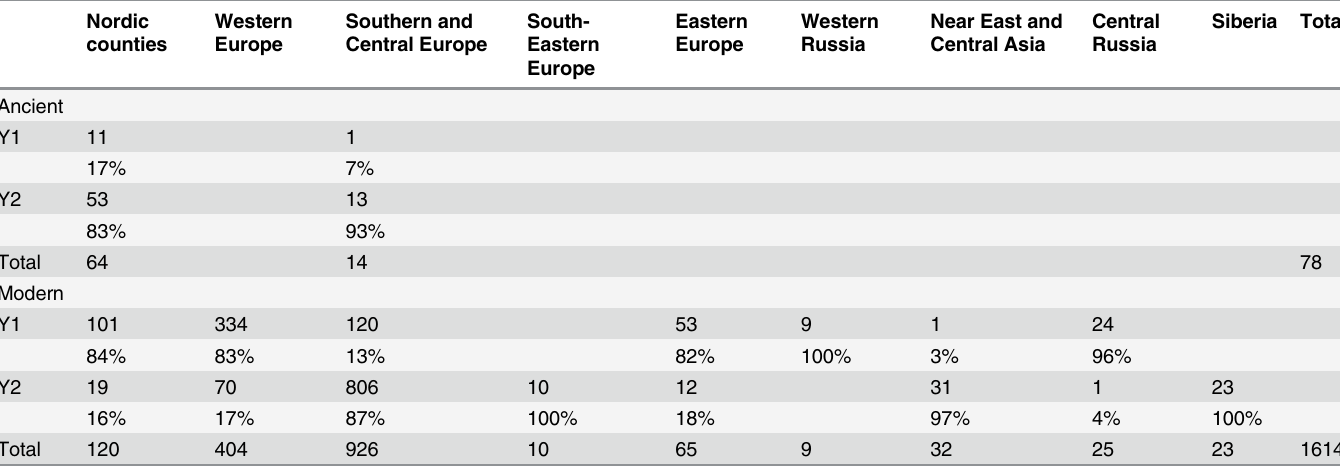
Data includes 78 ancient (from Finland, Sweden and Switzerland) and 1621 modern Eurasian bulls. Separate fi gures for each breed and ancient populations are given in Table E in S1